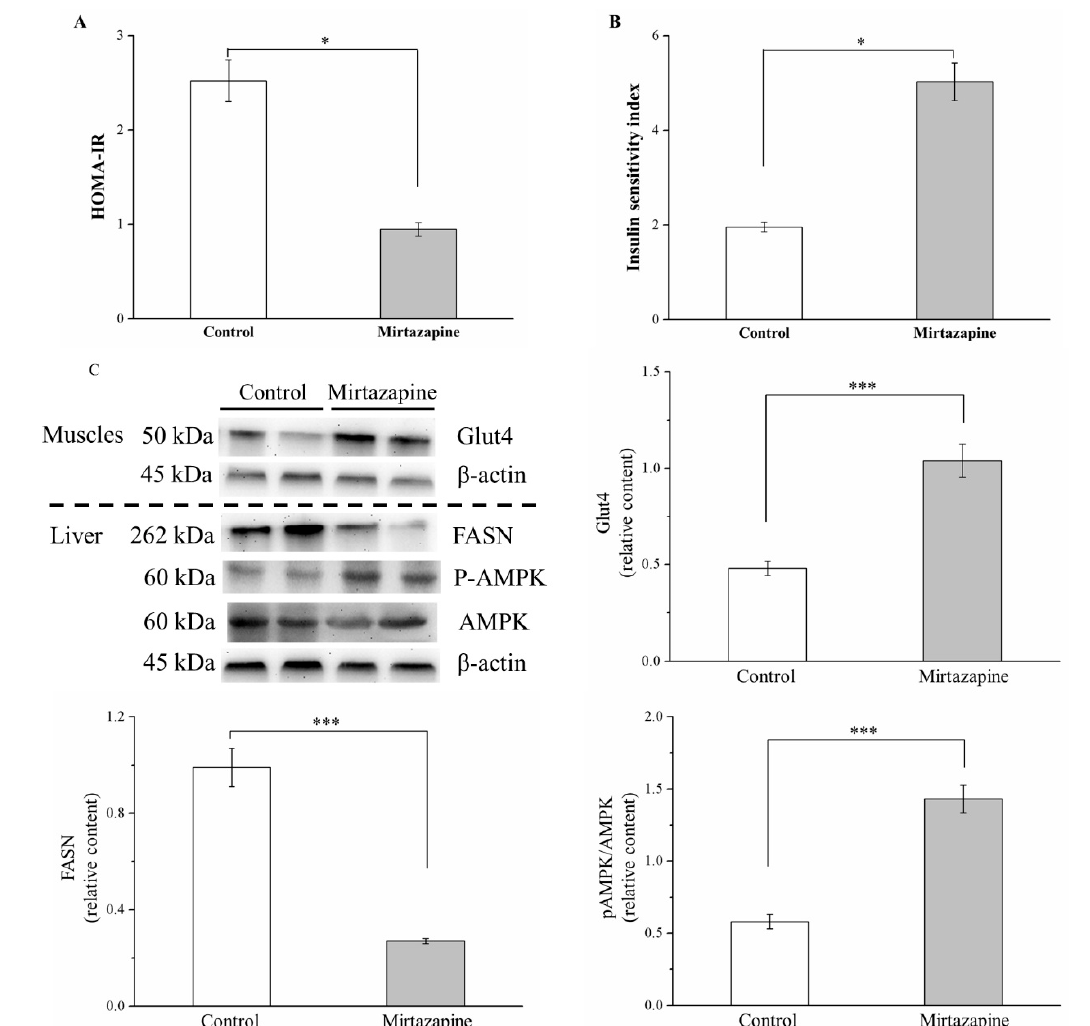
Figure 6. Changes in ( A ) homeostasis model assessment-insulin resistance (HOMA-IR) index, ( B ) insulin sensitivity index (ISI), and ( C ) GLUT4 expression in the gastrocnemius muscle and FASN and p-AMPK expression the liver in the control and 10 mg/kg/day mirtazapine-treated mice over the 28 treatment days. We present all data in this figure as mean ± SEMs (n = 10) for both groups. * p < 0.05, *** p < 0.001.